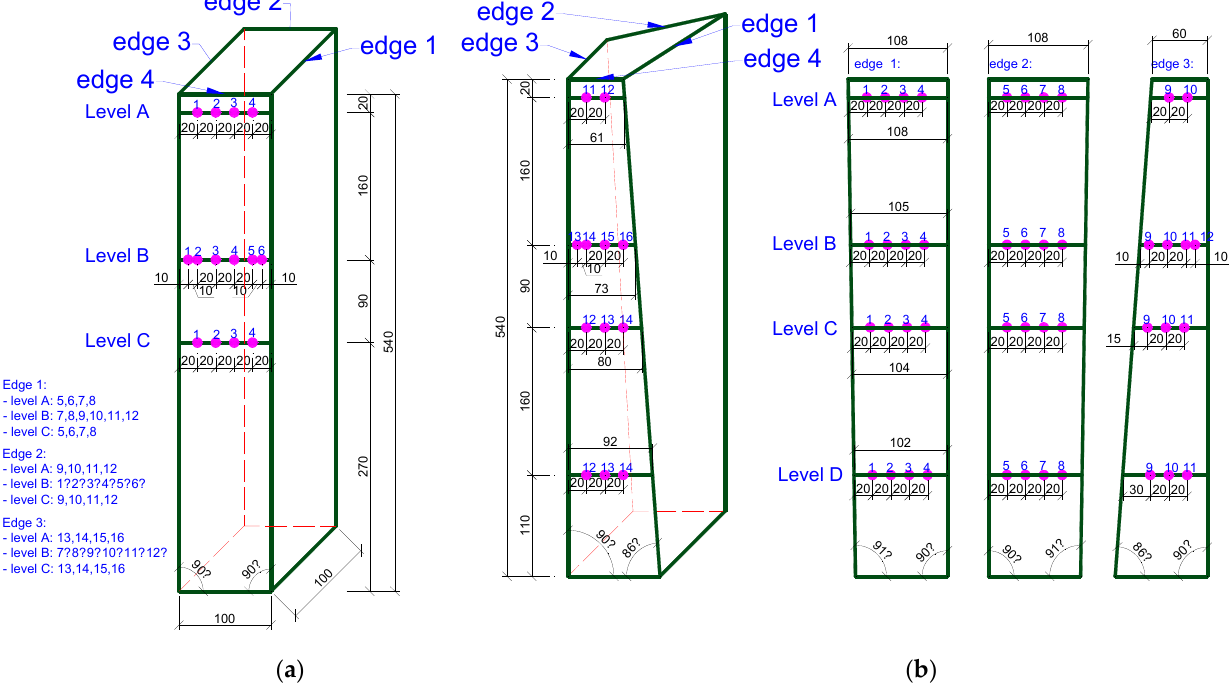
Figure 5. The dimensions and positions of measuring taps [in mm]. ( a ) The cuboid; ( b ) the atypical structure.